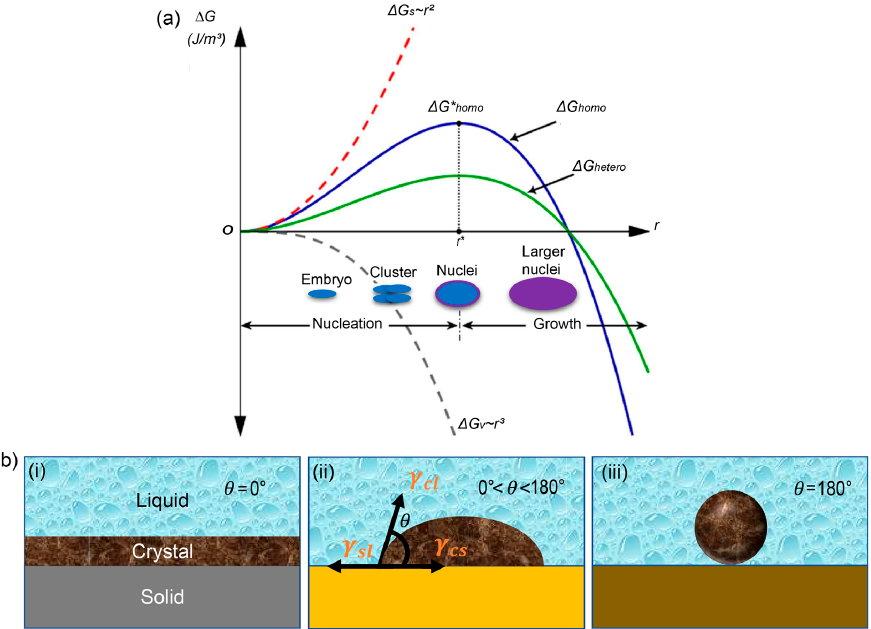
Figure 1. Nucleation and Gibbs free energy. ( a ) Illustration of changes in Gibbs free energy as a function of the particle radius, r, where changes in Gibbs free energy for surface, volume, homogeneous nucleation, and heterogeneous nucleation are denoted as Δ G s , Δ G v , Δ G homo , and Δ G hetero , respectively [58]. ( b ) Schematic of heterogeneous nucleation on a solid with different contact angles; (i) θ = 0 ˚ , (ii) 0˚ < θ < 180 ˚, and (iii) θ = 180 ˚ [59]. Reprinted with permission.